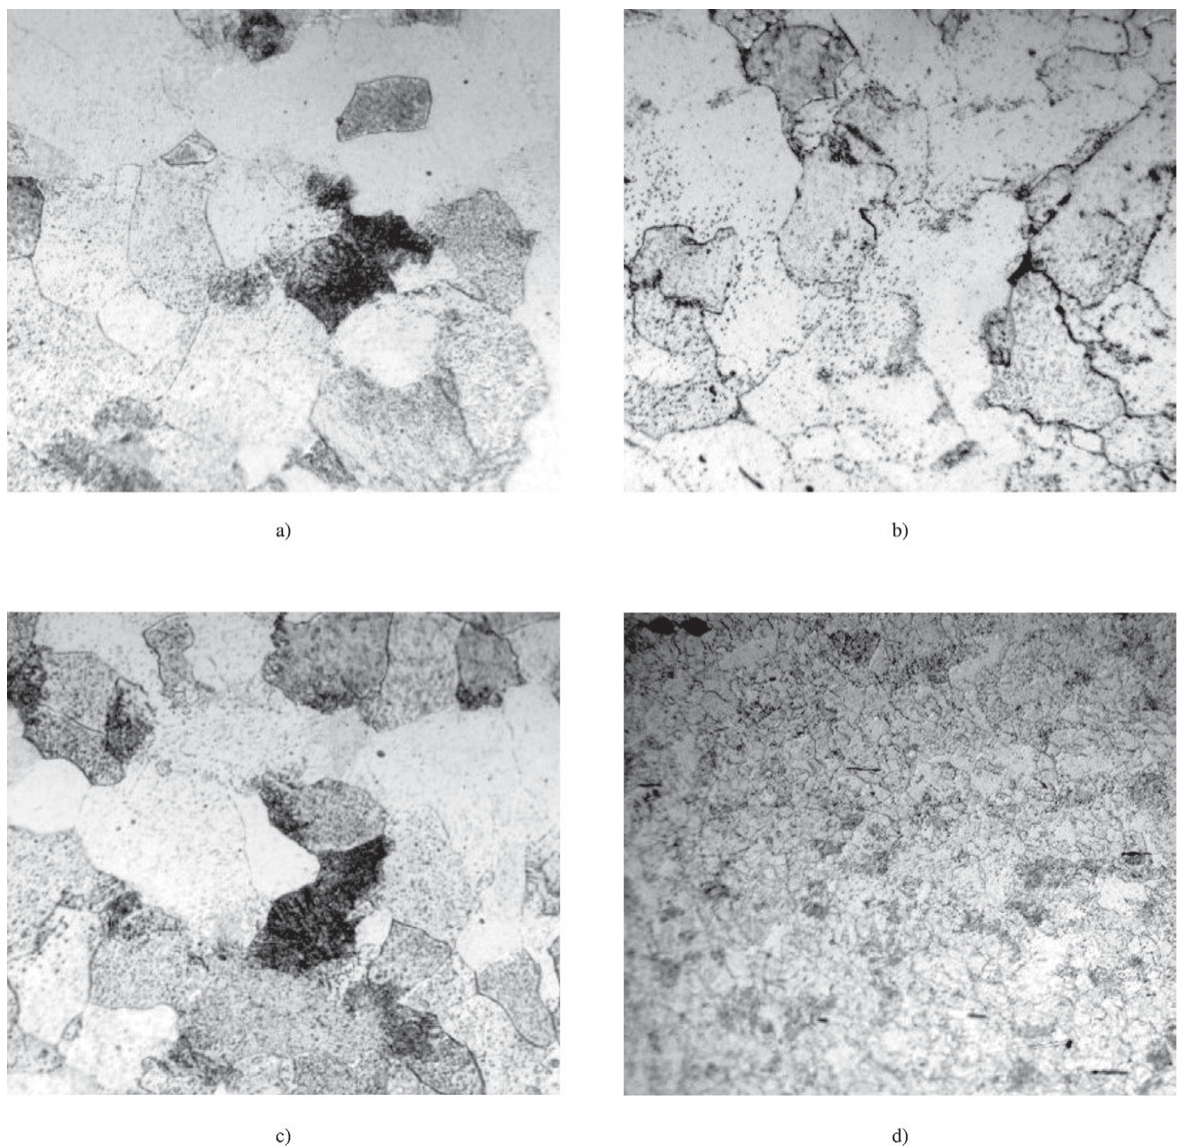
Figure 4. Optical microscopy, 950x: a) sample 10, with preserved (black arrows) and transformed (white arrows) pearlite; b) sample 3, showing 100% of transformed pearlite; c) sample 8, with preserved (black arrows) and transformed (white arrows) pearlite; d) heat affected zone of sample 6, showing pores, or cavities, (white circles) and oxides (black